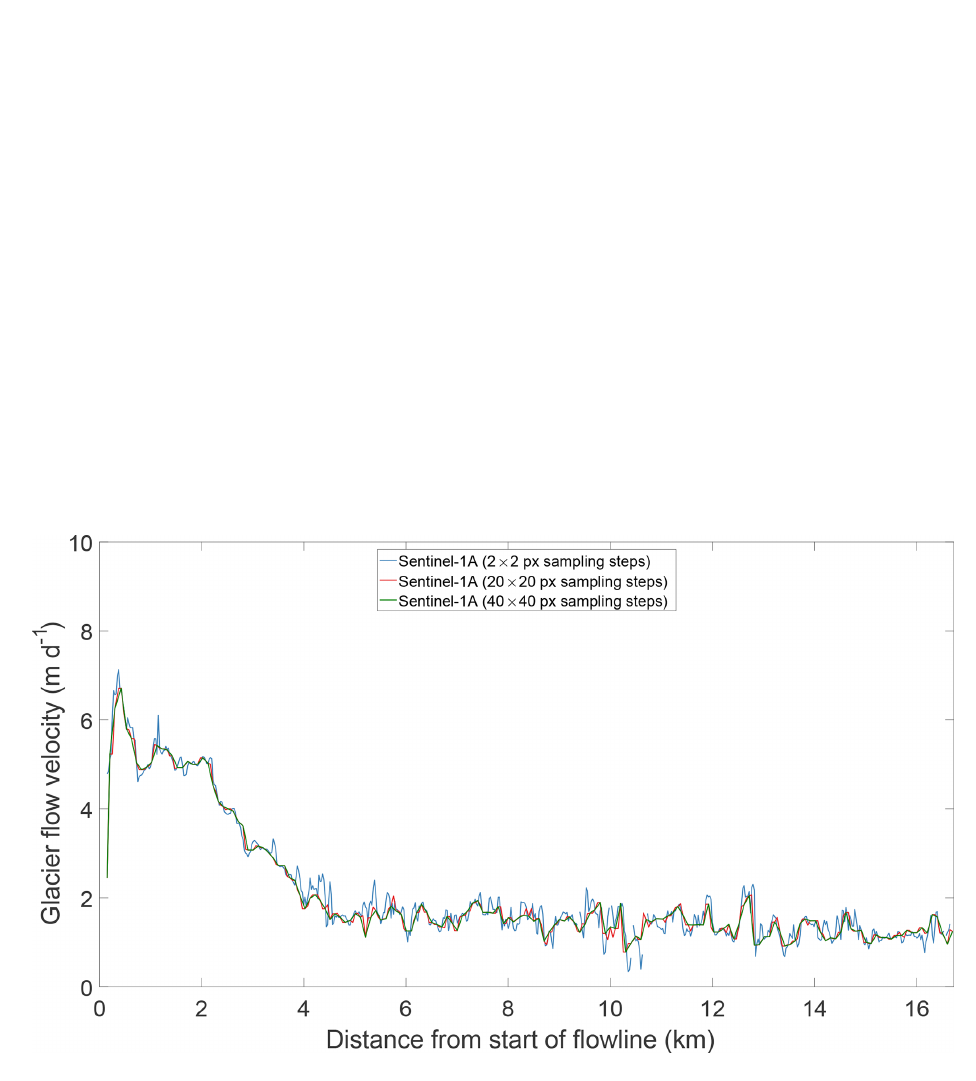
Figure A9. Mean flow speed along the central flowline (see Fig. 1) for different sampling step sizes derived from S1A scenes acquired between 8 July and 25 August 2016 (48d), starting at the glacier’s